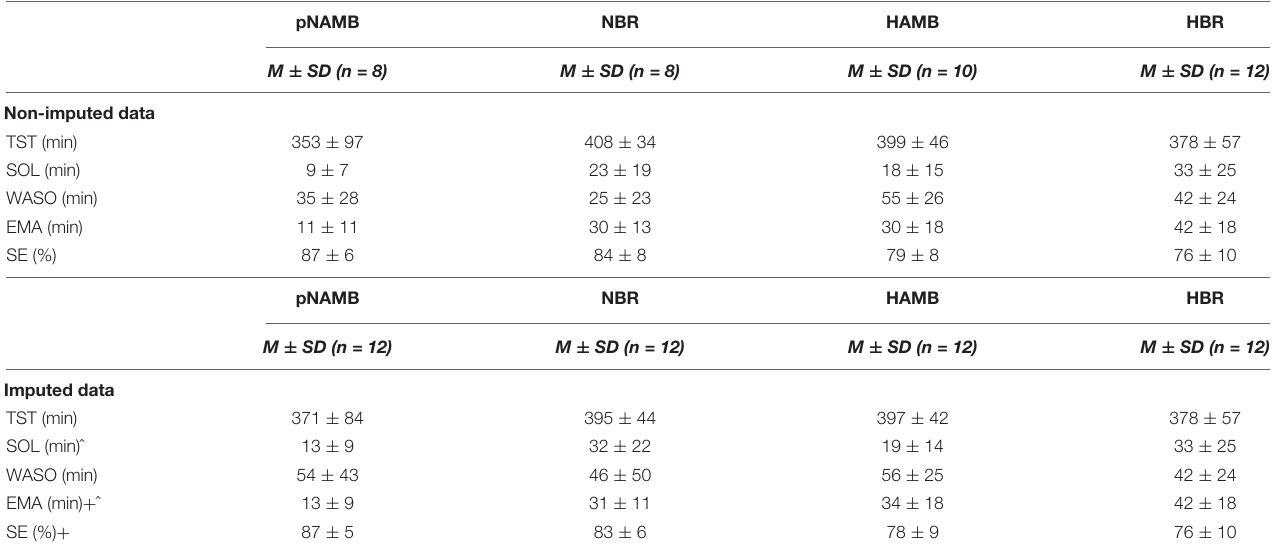
TABLE 1 | Overview of sleep maintenance and efficiency outcomes in each level of both independent variables (i.e., activity and PO 2 ).